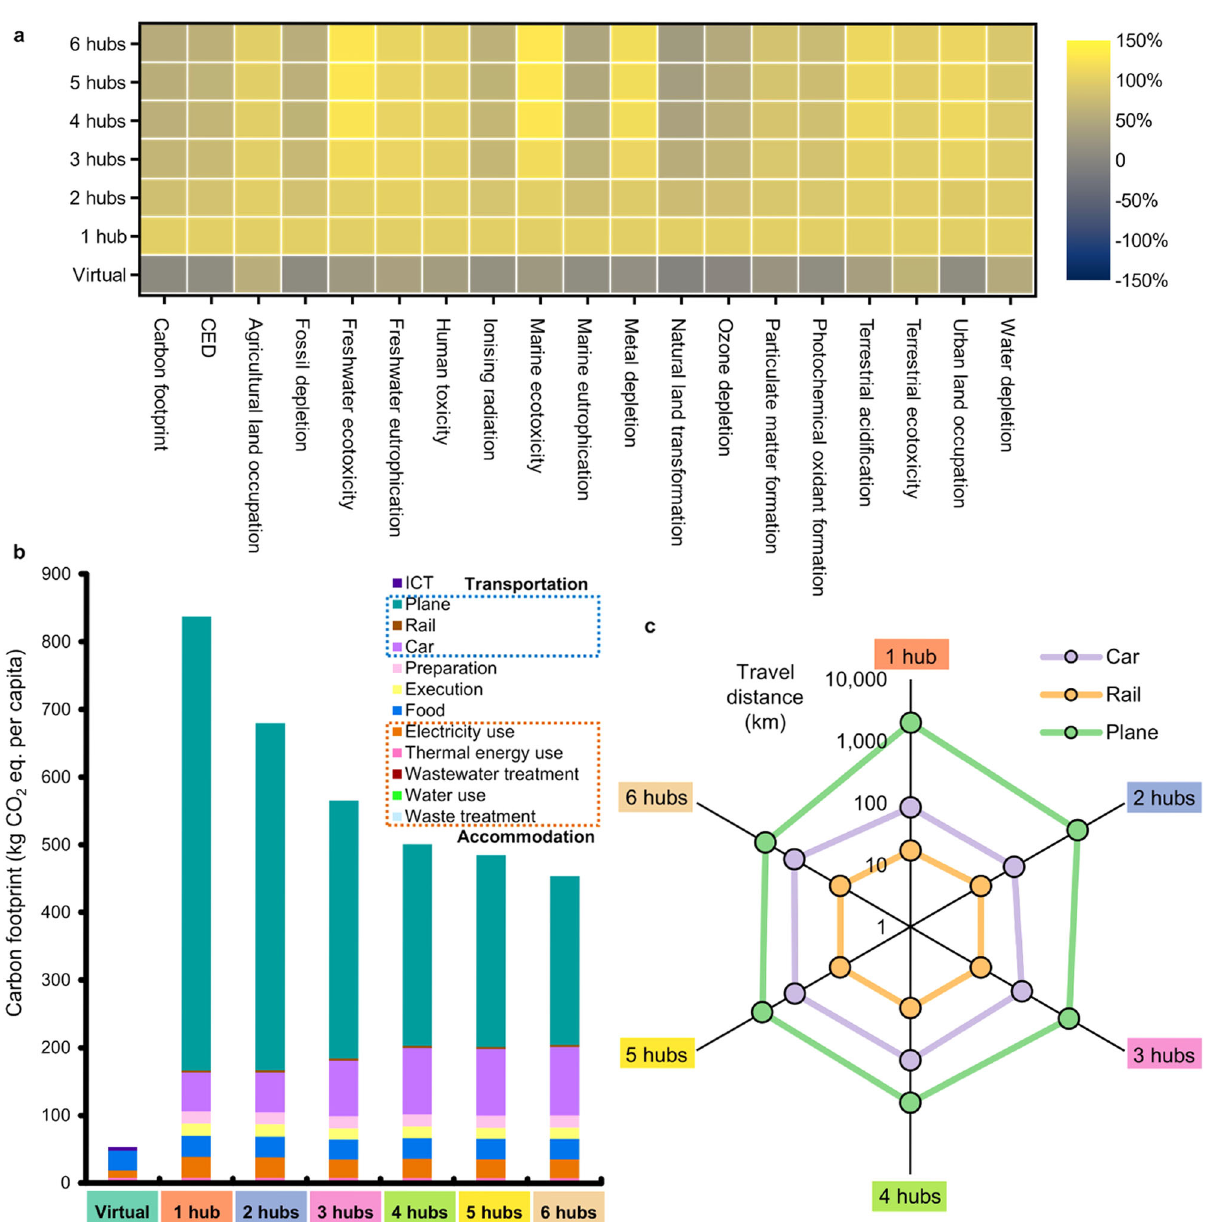
Fig. 4 Overall environmental sustainability of the virtual and in-person conferences. a Carbon footprint, Cumulative energy demand (CED), and 17 ReCiPe midpoint indicators of the in-person scenarios, including the virtual conference and in-person conferences with 1 to 6 hubs, for an average participant. Colors indicate the intensity levels of environmental impacts. b Breakdowns of carbon footprint per participant for the in-person scenarios. Colors represent different processes within the life cycle stages. c Average travel distances by transportation mode on a logarithmic scale for the in-person scenarios with 1 to 6 hubs. CO 2 eq., CO 2